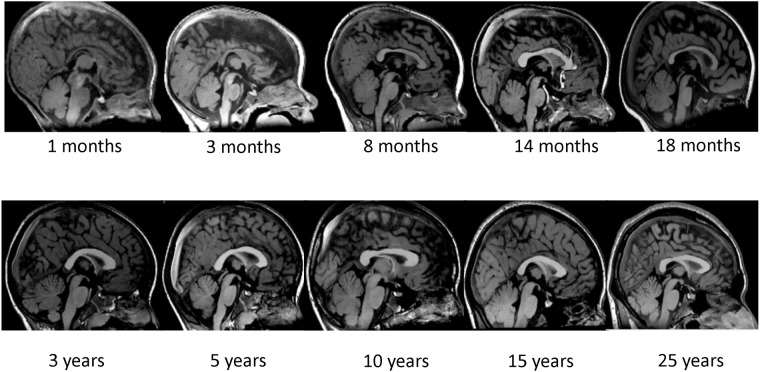
The samples of the corpus callosum on midsagittal MRI.